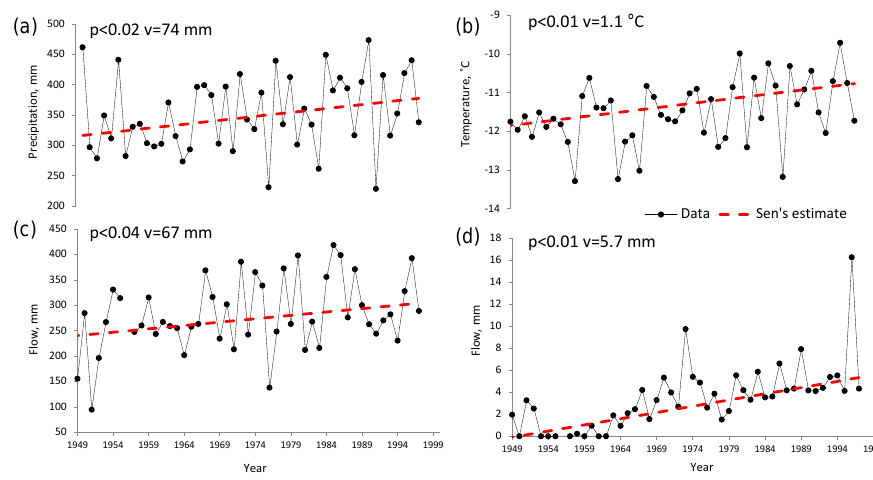
Figure 15. Trends of hydrometeorological elements, 1949–1997. (a, b) Annual precipitation (mm) and air temperature ( ◦ C) at the Nizhnyaya station; (c, d) annual and October flow (mm) at the Kontaktovy creek – Nizhny. p – statistical significance; v – trend